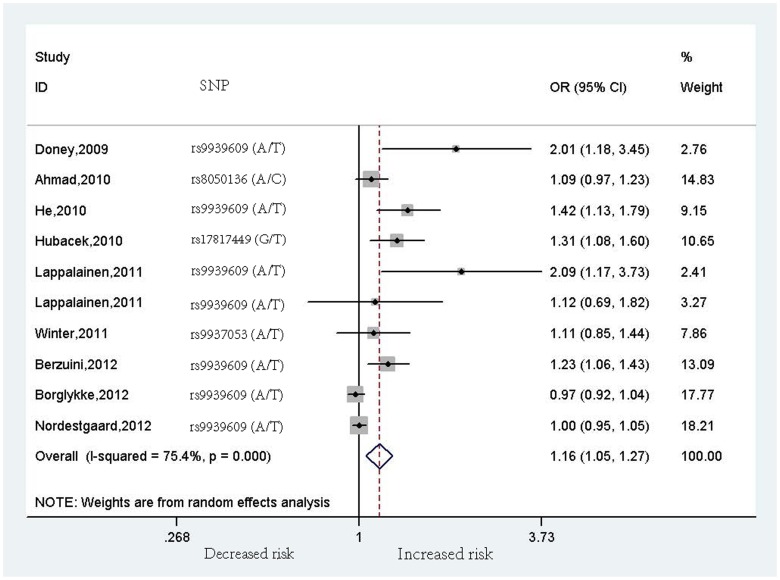
Meta-analysis of the association between rs9939609 (or its proxies) polymorphism in the FTO gene and cardiovascular disease risk after adjustment for BMI and other conventional CVD risk factors.OR is reported to increased CVD risk; weights are calculated from the inverse of their variance.